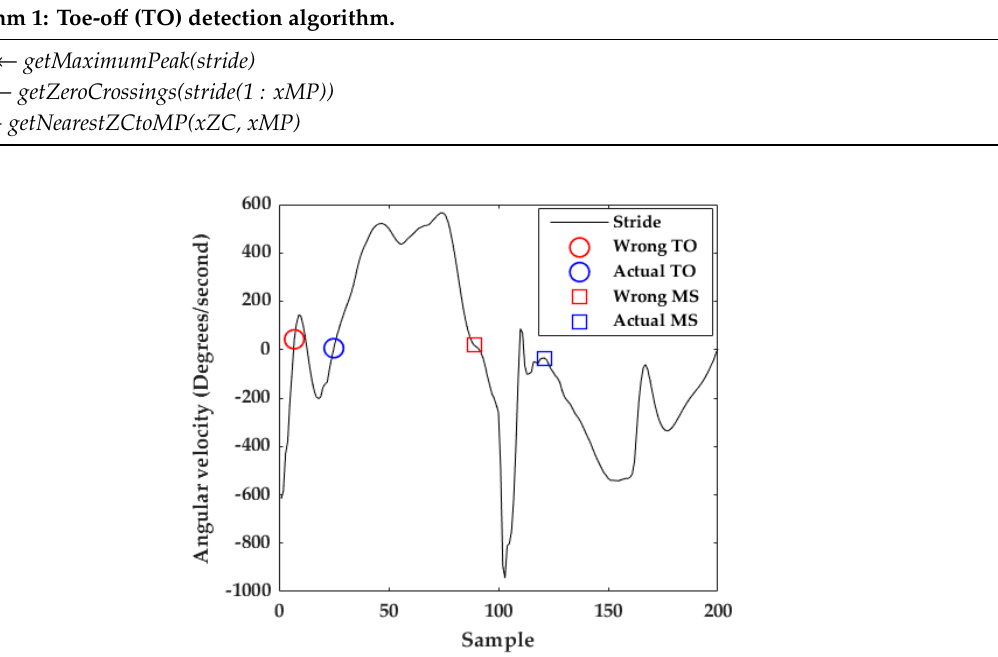
Figure 7. Threshold choice for stride segmentation of walking, jogging, and running strides using msDTW.